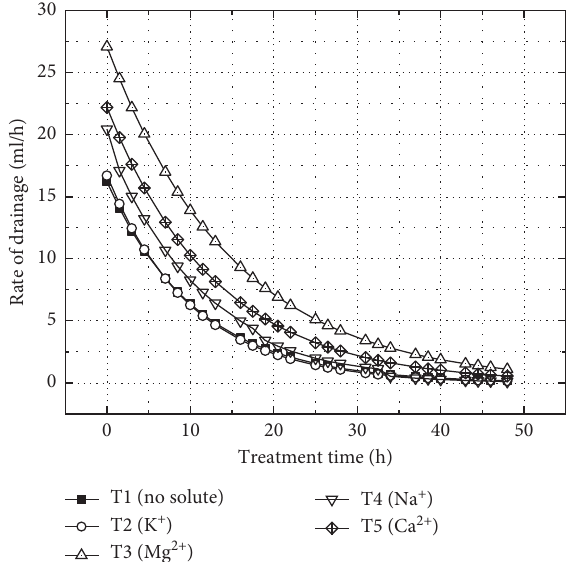
Figure 4: Drainage rate variations over treatment time.